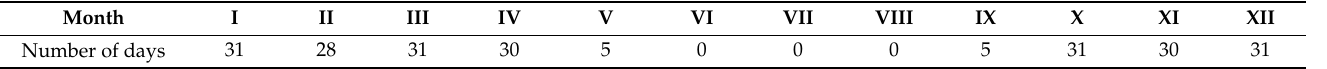
Table 1. Number of heating days per month in Cracow.